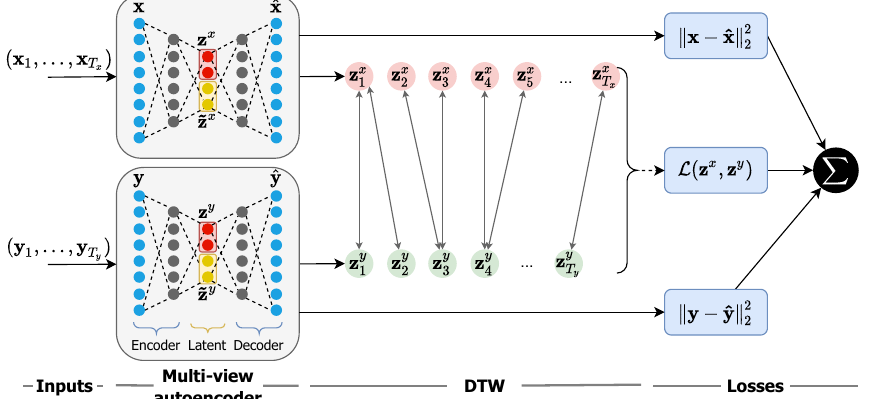
Figure 2. Block diagram of proposed TRANSIENCE algorithm for time series alignment. First, feature vectors of two sequences to be aligned are projected into a common, latent space (represented with red dots in figure) using DNNs trained for each view. Then, DTW algorithm is used to align resulting sequences of embedding vectors and, hence, original sequences. To train parameters of DNNs, different loss functions are employed (see text for more